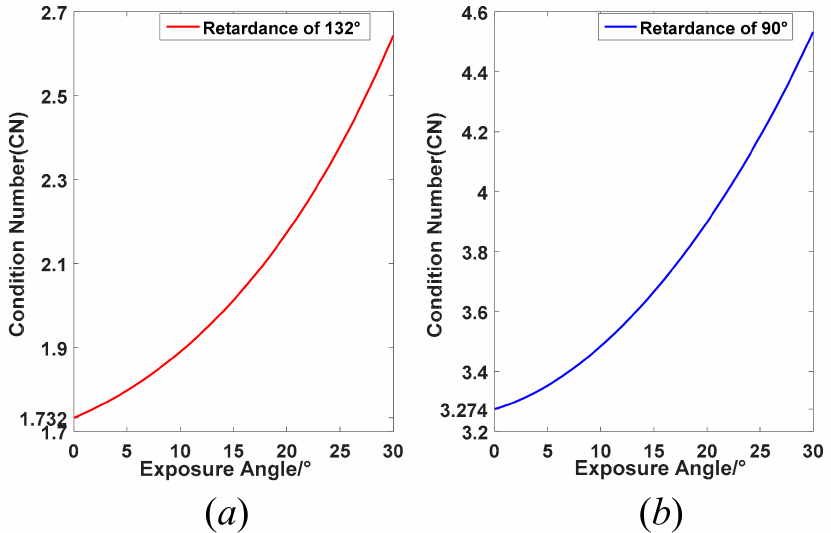
Figure 2. CN deviation from its well-conditioned value with increasing of the exposure angles.